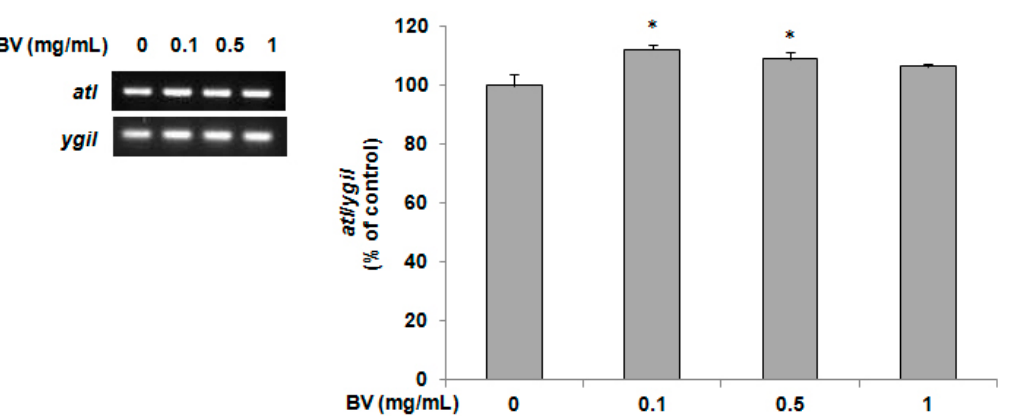
Figure 2. Reverse transcription-polymerase chain reaction for atl mRNA expression. The results show that BV treatment increases atl mRNA production in Methicillin-resistant Staphylococcus aureus MRSA 3366. Data are presented as mean ± SD values of three independent experiments. *: significant differences ( p < 0.05) with an increase in mRNA expression relative to the control.